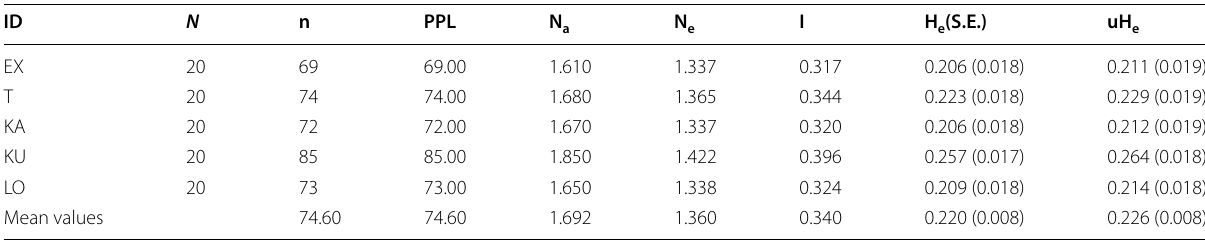
Table 6 Genetic variation in populations of Plantago maxima detected by inter-simple sequence repeat (ISSR) markers